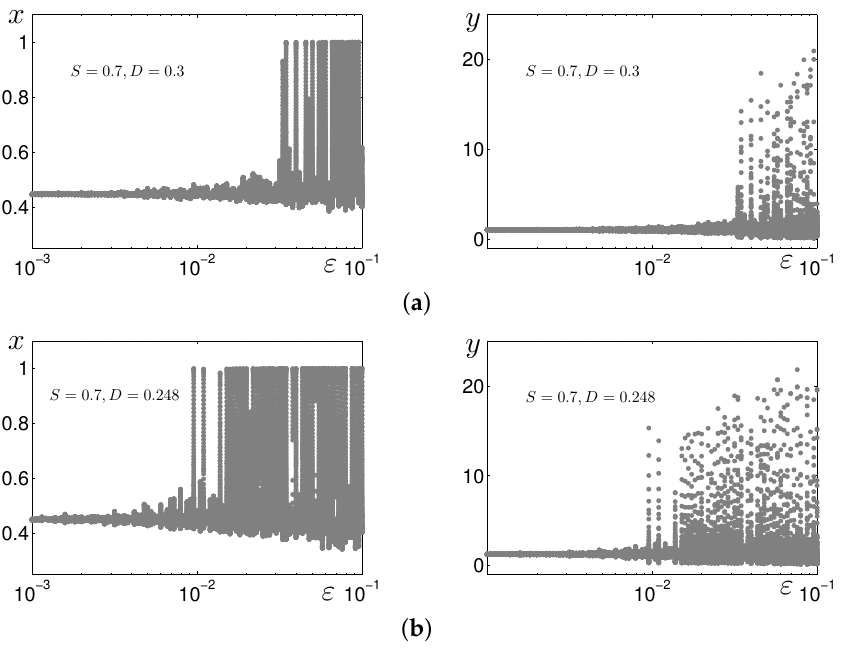
Figure 4. Random states of the system (2) for ( a ) D = 0.3, ( b ) D = 0.248.